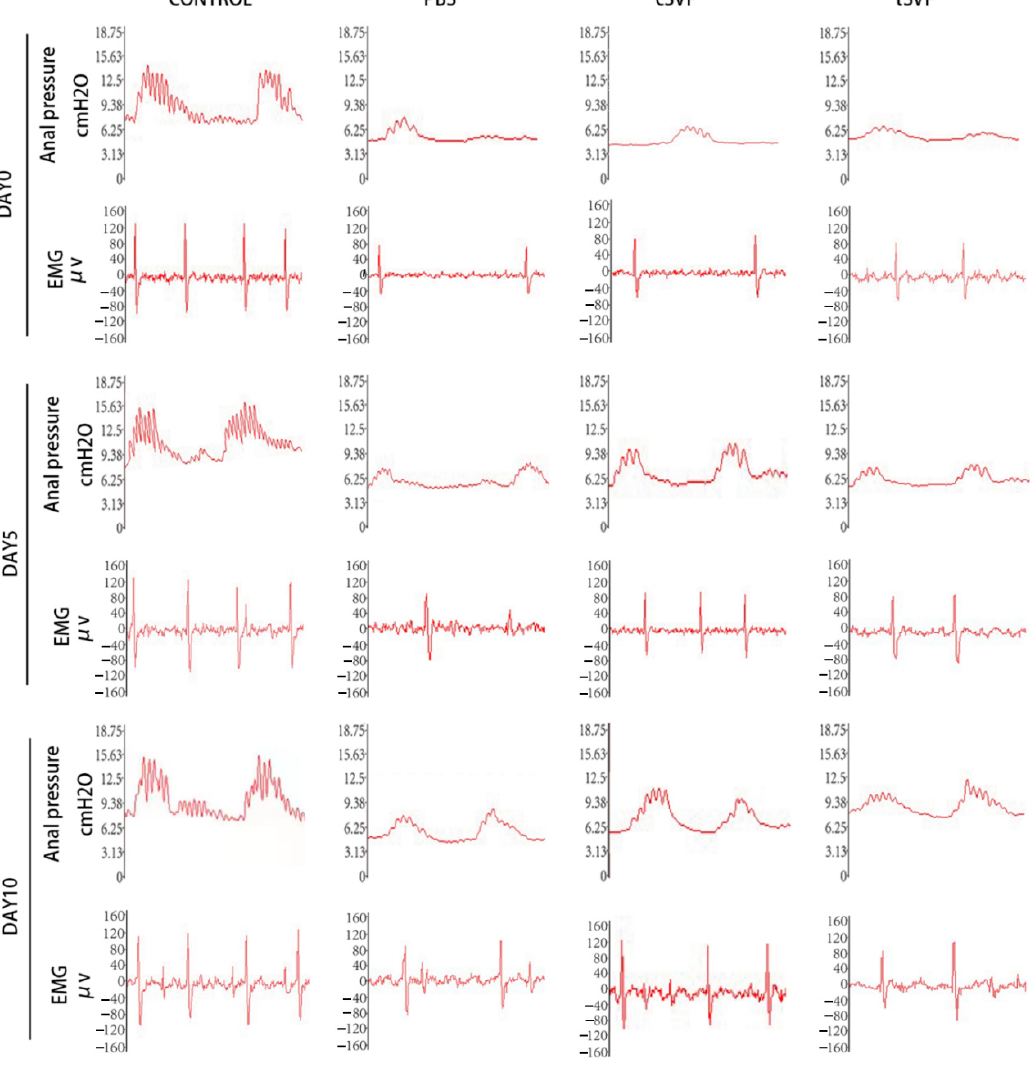
Figure 2. Waveforms of anal pressure and EMG in the control group, PBS group, cSVF group, and tSVF group were measured before treatment and at 5, 10 days after treatment. The waveform for anal pressure was recorded for 70 s, and the waveform for EMG was recorded for 160 ms.